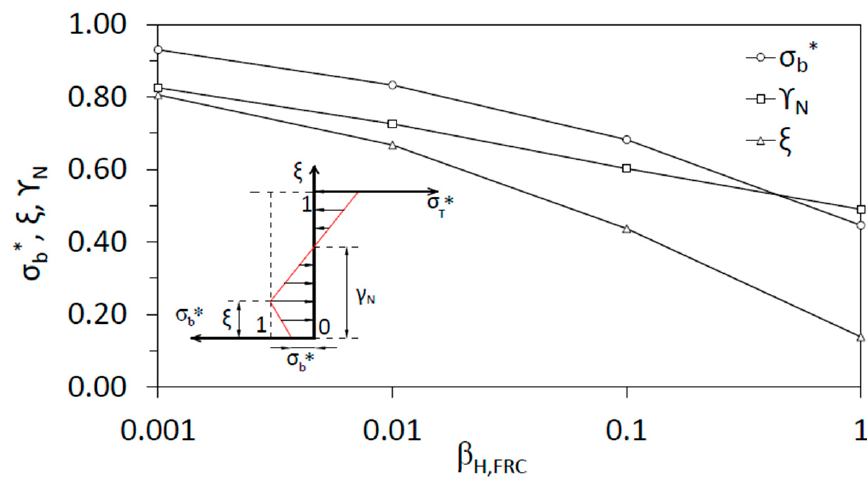
Figure 8. Non-dimensional stress at the bottom part of the beam, σ b * , non-dimensional neutral axis depth, γ n , and non-dimensional crack depth, ξ , as a function of the brittleness number, β H,FRC .